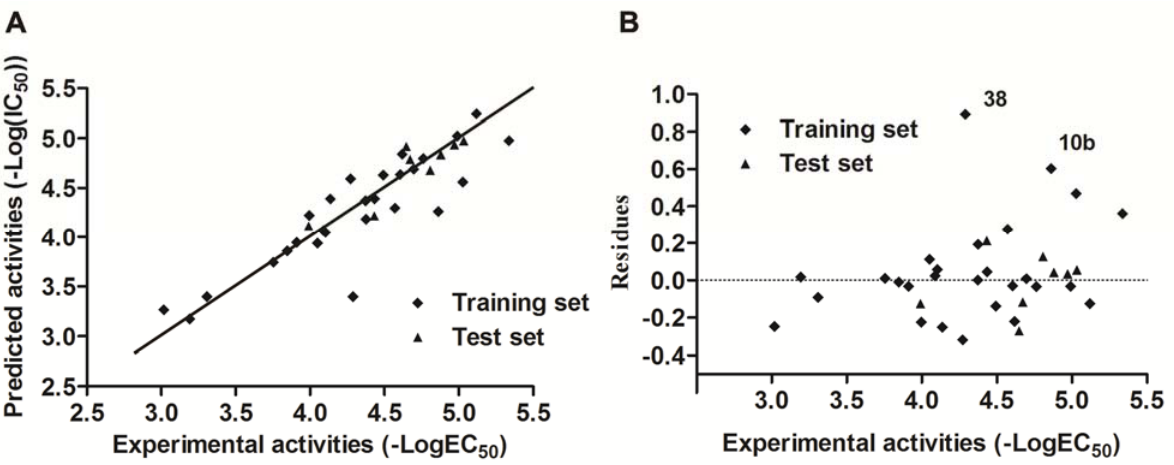
Figure 4. Predicted vs. experimental vasorelaxant activities ( − LogEC model developed by